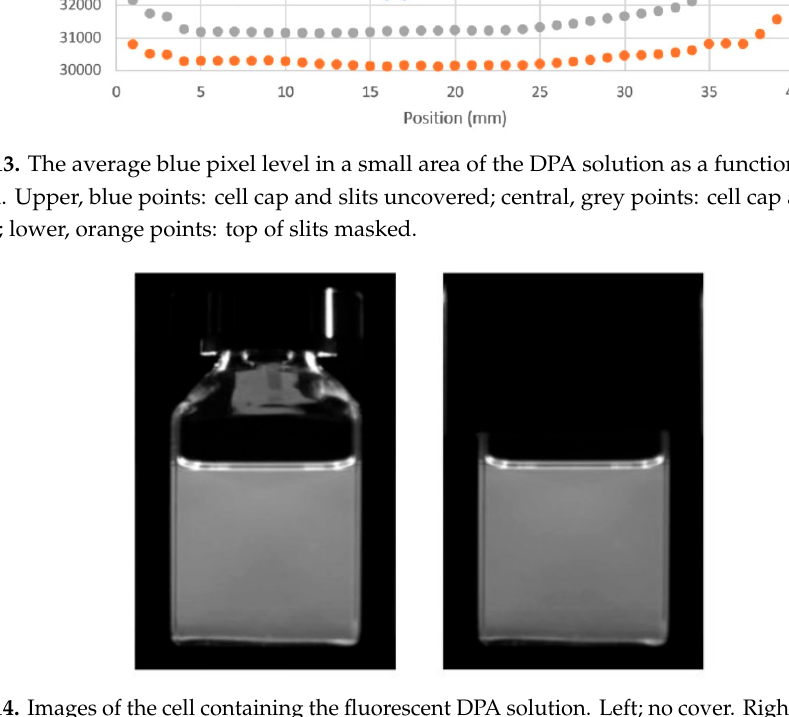
Figure 14. Images of the cell containing the fluorescent DPA solution. Left; no cover. Right; black paper cover over cap and shoulder of the cell.